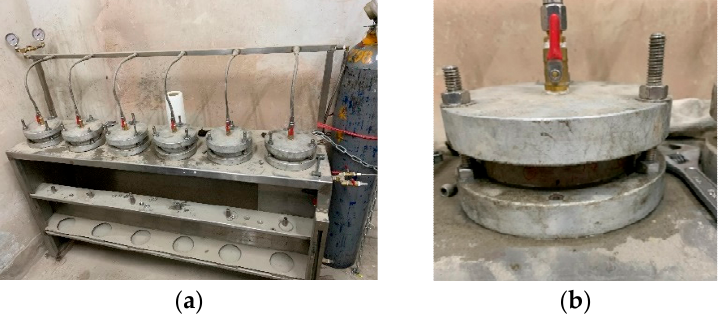
Figure 7. Water penetration test setup: ( a ) the case of six specimens; ( b ) the case of a single specimen.